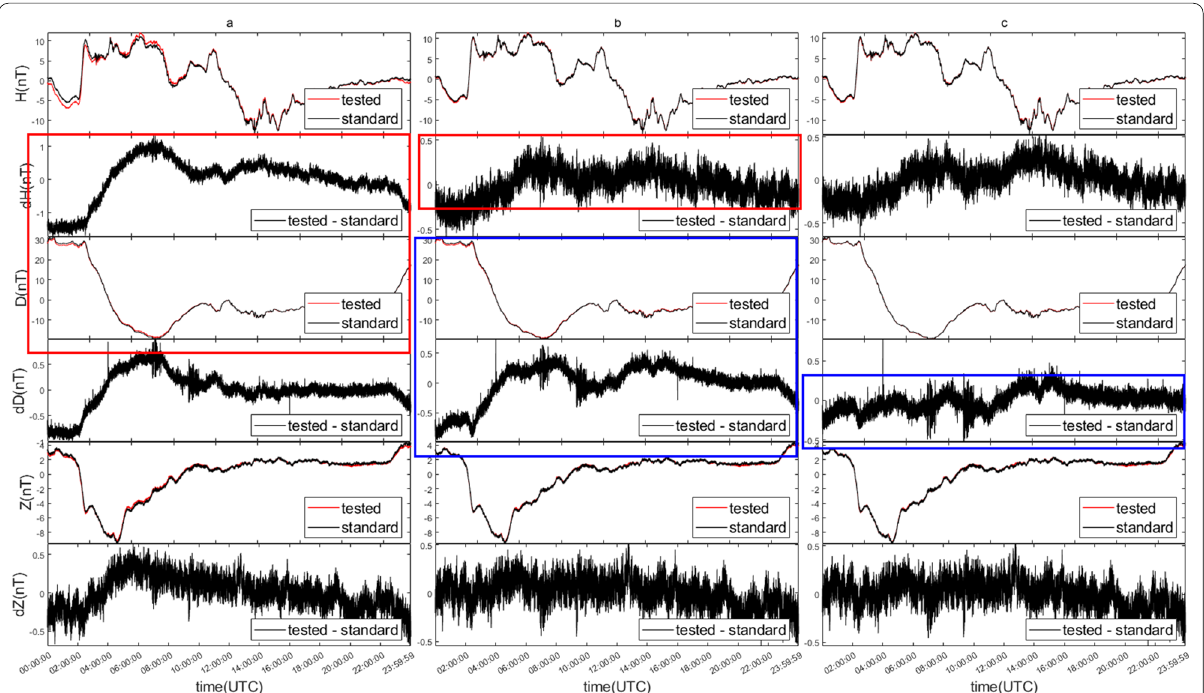
Fig. 4 Daily correction effect. The figure shows the daily geomagnetic variations and the vector differences on June 17, 2020, at YUL a before corrections (see explanations in Fig. 1) and b after attitude angle corrections only, c after both attitude angle and scale factor